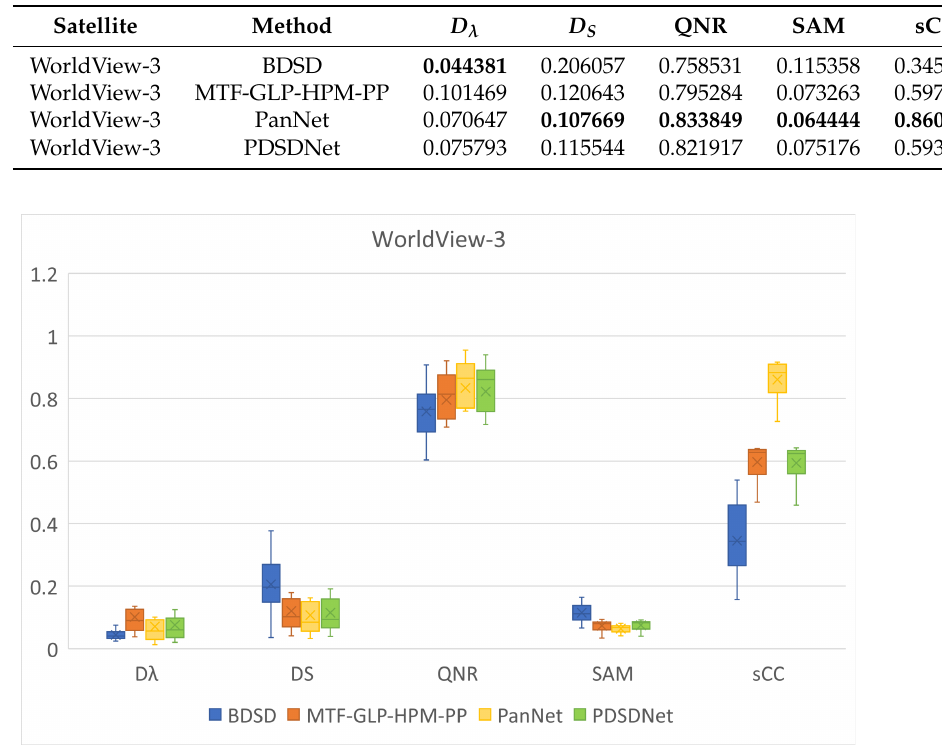
Table 6. Quality indexes of WorldView-3 test images.